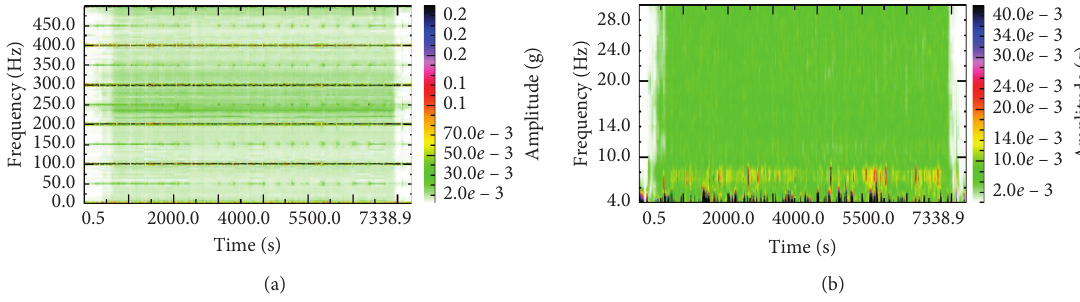
Figure 15: Spectrum of lateral acceleration on CBSE traction transformer: (a) zoomed; (b) enlarged.